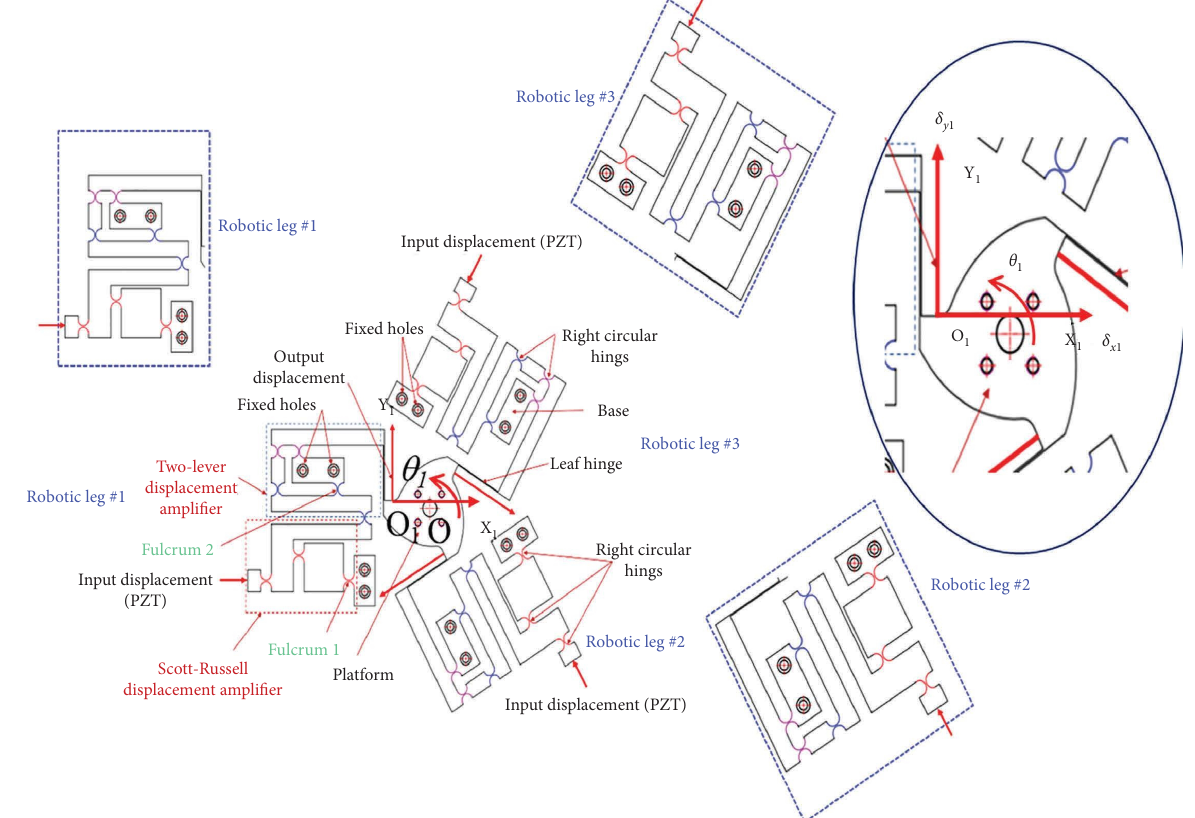
Figure 1: Design scheme of XYθ mobile positioning microrobotic